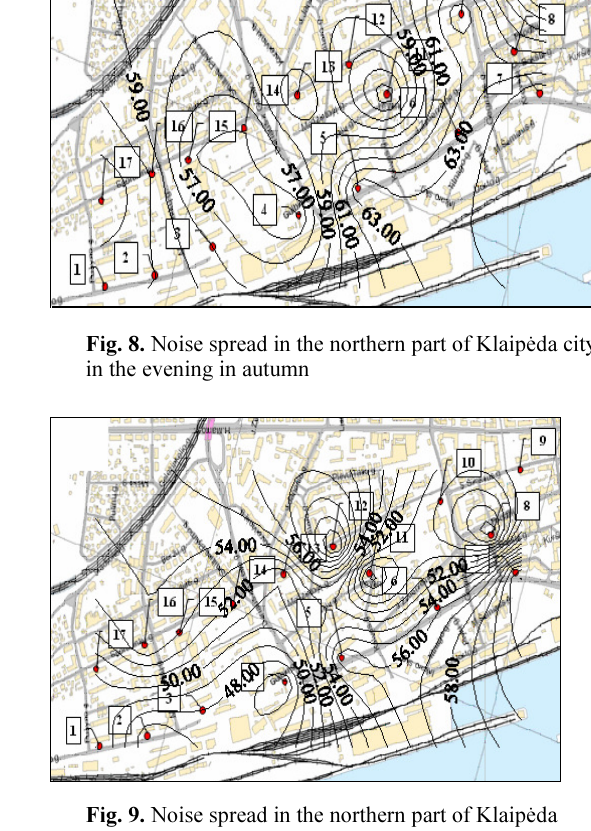
Fig. 9. Noise spread in the northern part of Klaipėda city at night in summer in the hereabouts of Švyturio Street. The highest excess of noise level amounted to 8 dBA was in Naujojo Uosto Street. Permissible noise level was not exceeded at the measurement location No. 8 in Puodžių Street. Permissi- ble noise level was exceeded by 2 dBA at the measure- ment locations No. 9 and No. 10. Sound level was also exceeded up to 6 dBA in I. Kanto Street. Permissible noise level was exceeded by 4 dBA in Sportininkų